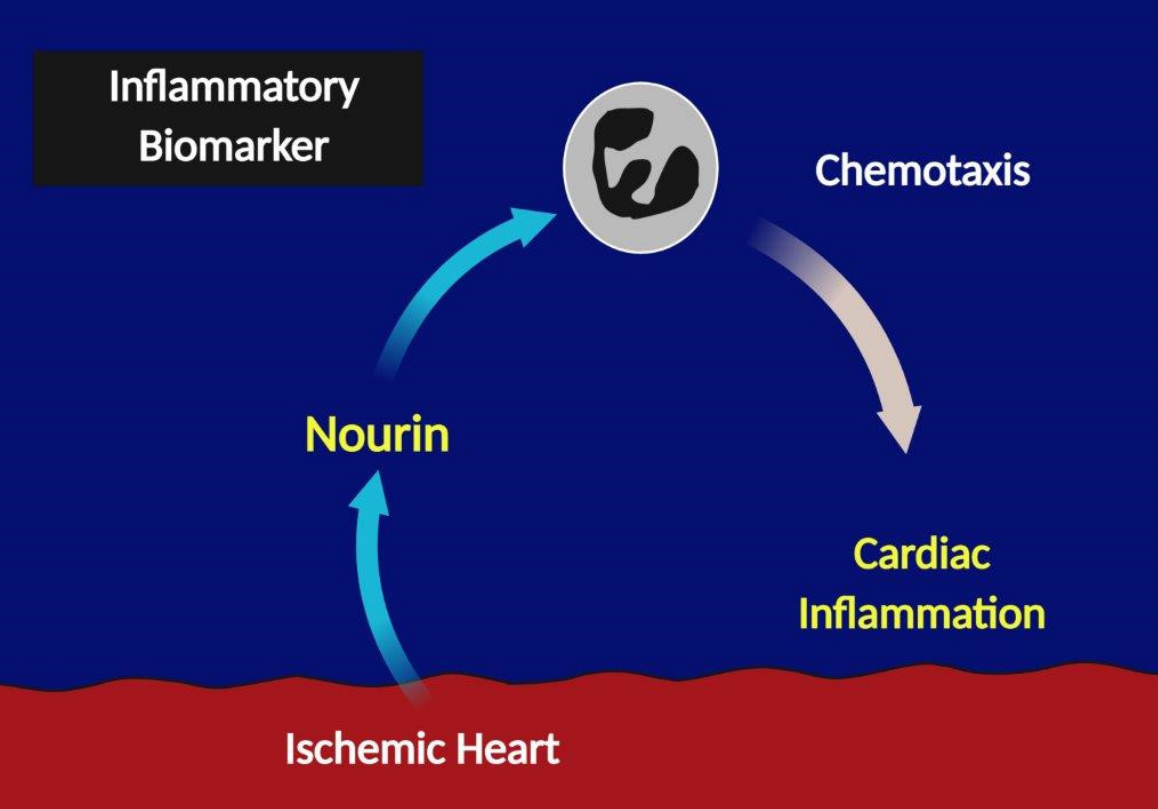
Figure 1. Schematic diagram illustrating the release of the leukocyte chemotactic factor Nourin by ischemic myocardium, followed by leukocyte recruitment and cardiac inflammation.